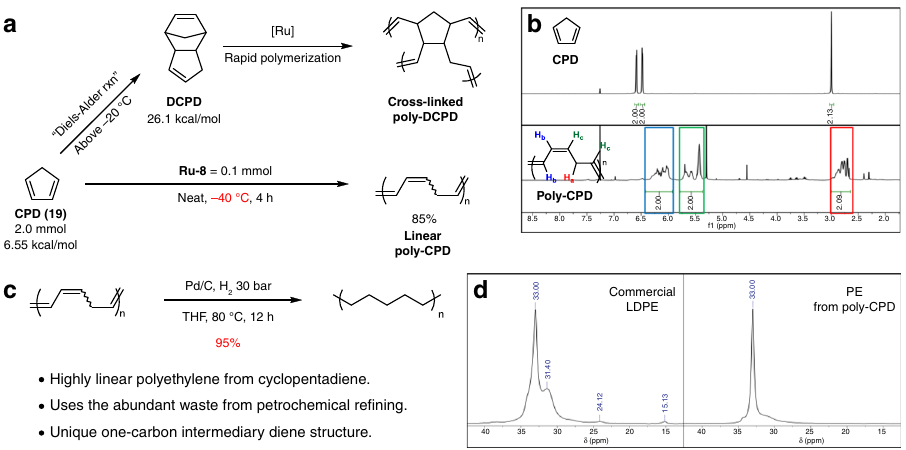
Fig. 6 ROMP of cyclopentadiene. a Dimerization of CPD at ambient temperature. b ROMP of CPD at − 40 °C with Ru-8 . Conversion was calculated from the 1 H NMR spectrum. No reaction was observed with G-II or G-III under same conditions. c Post-treatment of poly-CPD . Without puri fi cation, the crude poly-CPD was directly dissolved in THF and hydrogenated in quantitative yields. d Comparing polyethylene samples by solid-state 13 C NMR spectroscopy; commercially available low-density polyethylene (left), polyethylene via hydrogenation of poly-CPD (right) NATURE COMMUNICATIONS| (2019) 10:3860